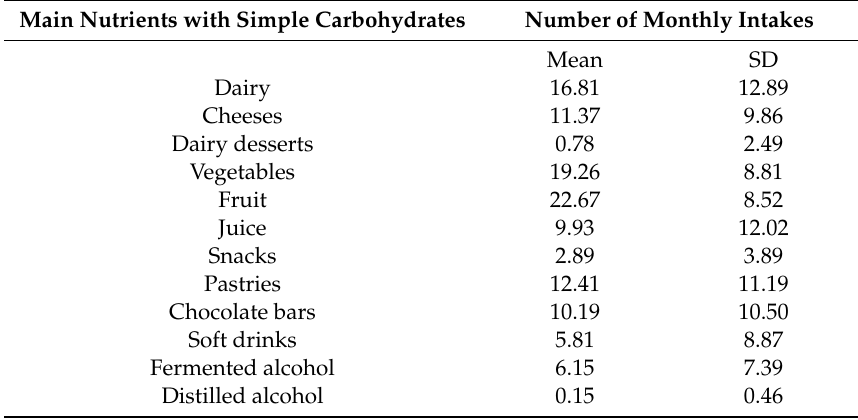
Table 2. Dietary habits of the study population related to the consumption of nutrients rich in simple carbohydrates.